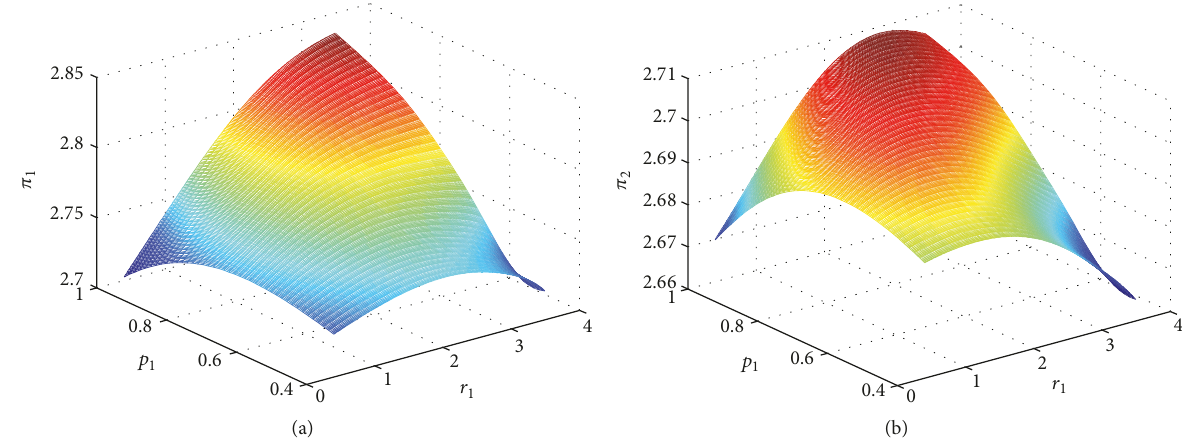
Figure 16: The average profits with respect to initial 𝑟 1 and 𝑝 1 when 𝜃 = 0.5 , 𝛼 = 0.5 , 𝑤 1 = 𝑤 2 = 0.5 , and 𝛼 1 = 𝛼 2 = 0.2 .